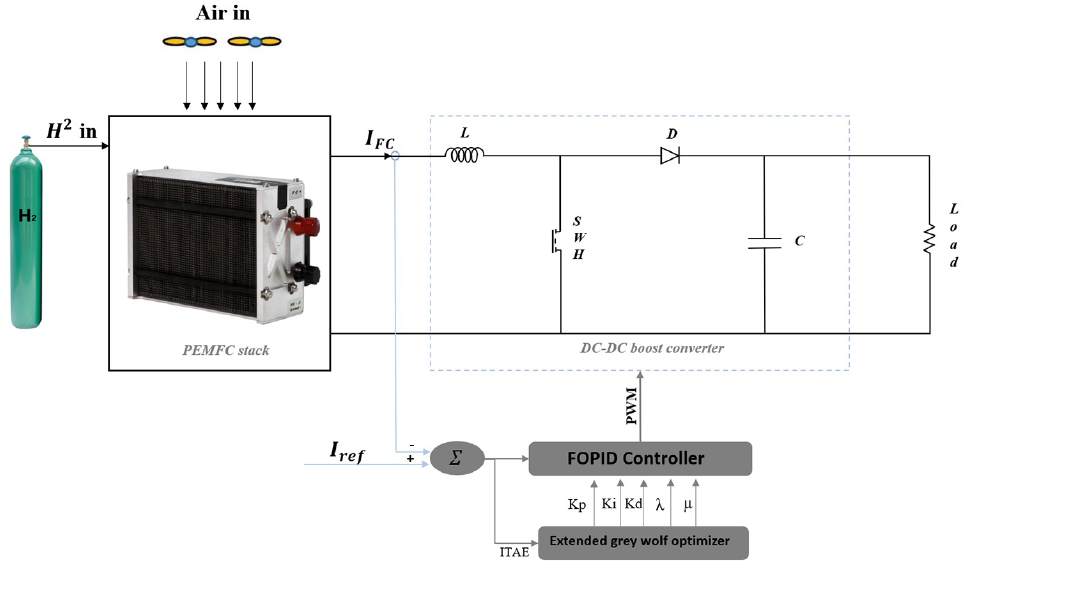
Figure 2. Principle of indirect adaptation with control